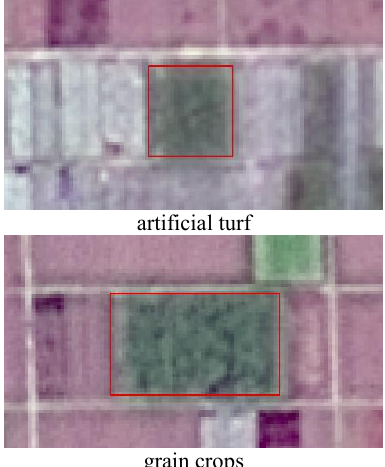
Figure 3. artificial turf and grain crops are difficult to distinguish in the image of one phase